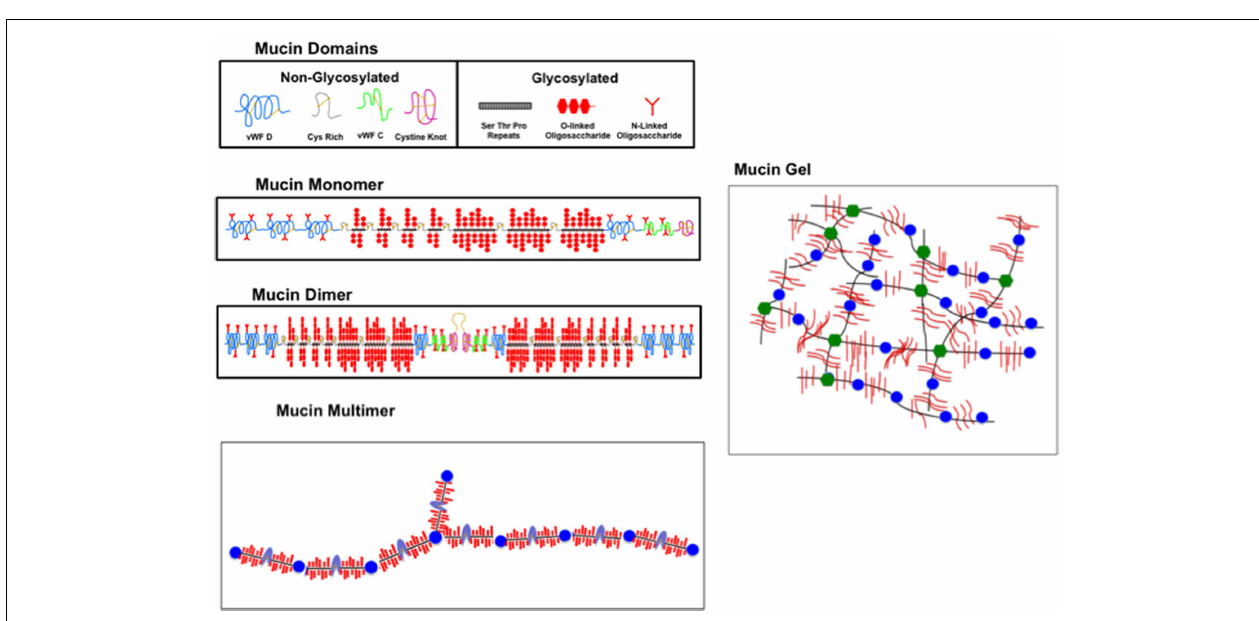
monomers linked with a disulfide (S–S) bond involving the C-terminal cysteine knot domains. (Bottom panel) A multimer with alternating g (black with red brush) and ng (blue) domains. An N-terminal branch is also indicated. (Right hand panel) A sketch of a mucin gel formed by hydrophobic association of unfolded ng domains of the multimer.The crosslinking is represented by changing the color of ng domains from blue to green. New sketch based in part on Ref. (48) with permission from